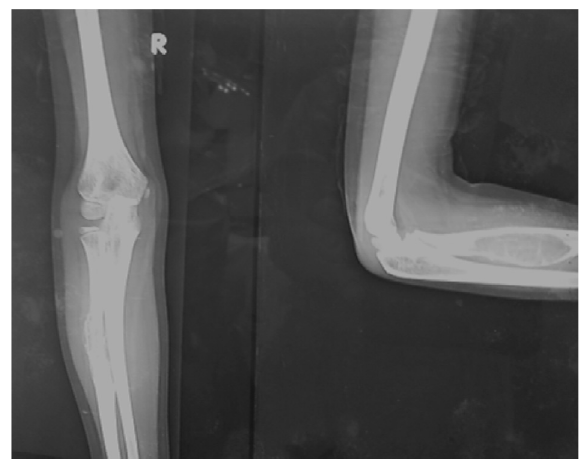
Figure 1. Initial anteroposterior and lateral views of roentgenograph showing an expansile lytic lesion in proximal half of the